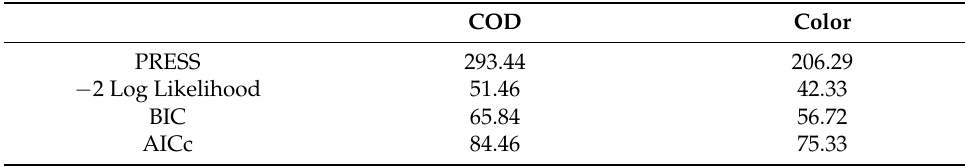
Table 6. Model comparison